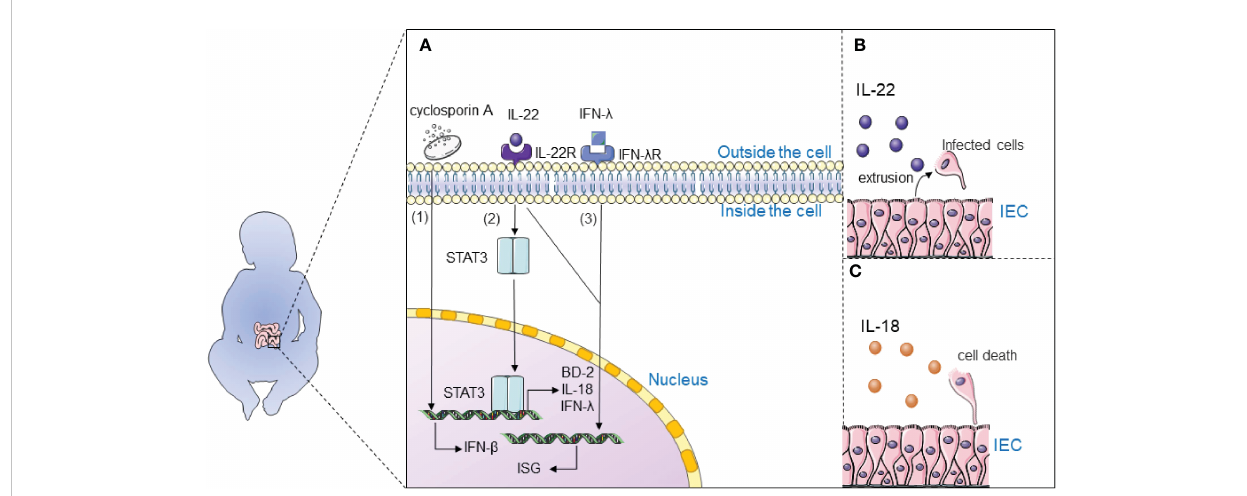
FIGURE 4 Immunotherapy inhibits rotavirus infection. (A) 1) Cyclosporine A may inhibit rotavirus infection by regulating the expression of IFN- b to activate the intracellular IFN1-based immune response; 2) Interleukin-22 (IL-22) inhibits rotavirus infection by activating the STAT3 signaling pathway and upregulates the expression of antimicrobial genes in the gut, including antimicrobial peptide b -defensin (BD-2), cytokine IL-18, and interferon- l (IFN- l ); 3) Interferon- l and IL-22 synergistically induce interferon-stimulated genes (ISG) and control rotavirus infection; (B) IL-22 extrudes cells from tissues by stimulating the proliferation of infected intestinal epithelial cells (IECs) and their migration toward the tips of the villi; (C) IL-18 promotes death of infected IECs to directly interrupt the viral replication